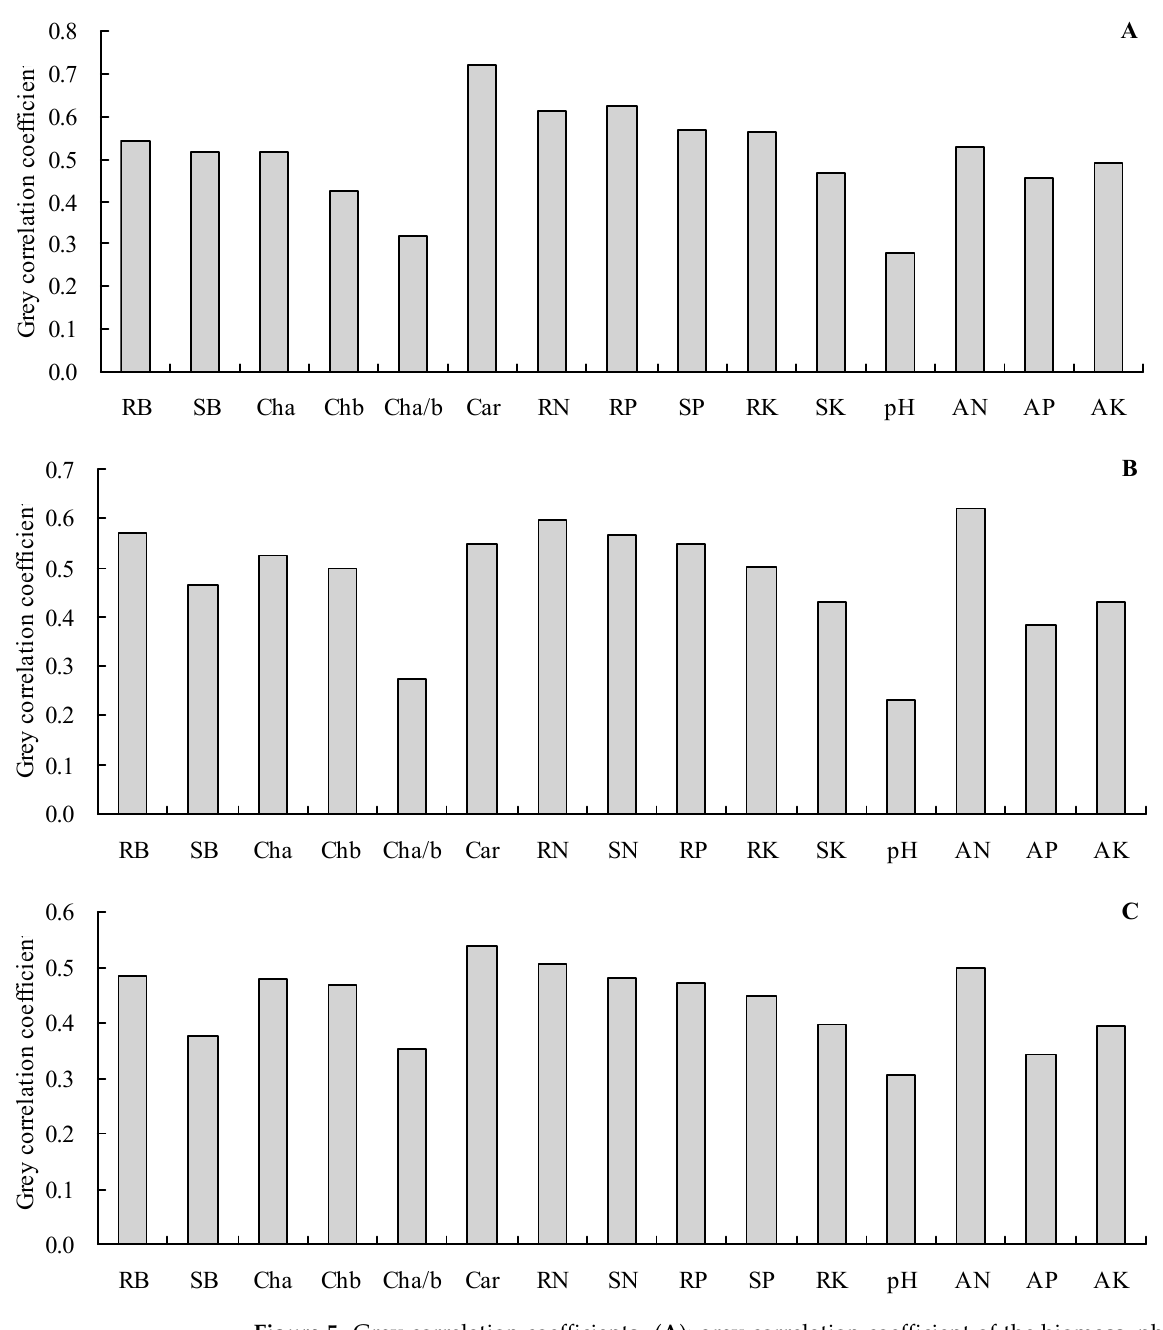
Figure 5. Grey correlation coefficients. ( A ): grey correlation coefficient of the biomass, photosyn- thetic pigment content, root N content, P content, and K content with the shoot N content; ( B ): grey correlation coefficient of the biomass, photosynthetic pigment content, N content, root P content, and K content with the shoot P content; ( C ): grey correlation coefficient of the biomass, photo- synthetic pigment content, N content, P content, and root K content with the shoot K content. RB = root biomass; SB = shoot biomass; Cha = chlorophyll a content; Chb = chlorophyll b content; Cha/b = chlorophyll a / b ; Car = carotenoid content; RN = root total N content; SN = shoot total N content; RP = root total P content; SP = shoot total P content; RK = root total K content; SK = shoot total K content; pH = soil pH value; AN = alkali-hydrolyzable N concentration; AP = available P concentration; AK = available K